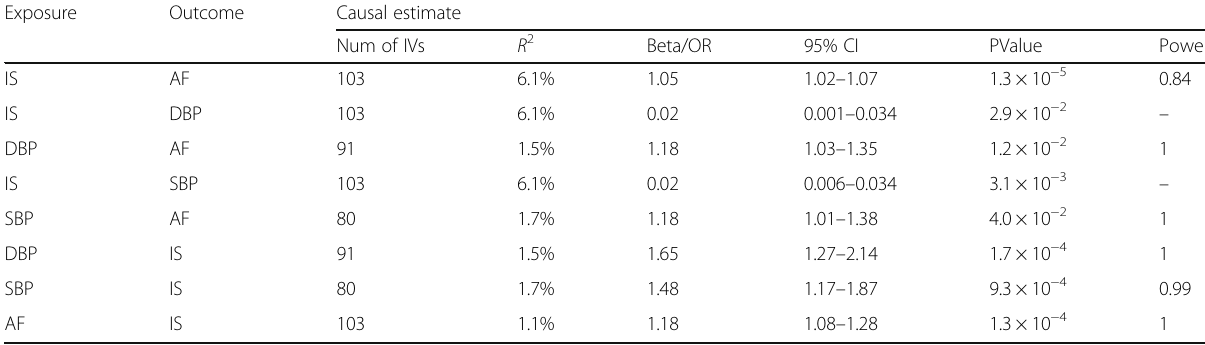
Table 3 Causal estimates for the association between IS and AF and mediators Exposure Outcome Causal